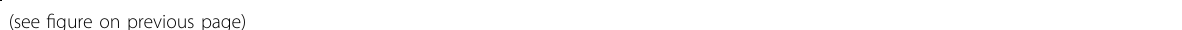
Fig. 6 Identi fi cation of CDCA3 as an miRNA target oncogenes. A Heatmap analyses demonstrating differentially expressed mRNAs in HCC with | log2fold-change | > 1.0 and P < 0.05. B , C Venn analysis between predicted mRNA genes targeted by miR-145-5p and differentially expressed mRNAs identi fi ed four mRNAs, NTN4, CDCA3, SLC25A25 , and SLC1A2 involved in HCC. D – G CDCA3 is signi fi cantly upregulated in HCC tumors and is associated with poorer OS. H Expression of CDCA3 between ten HCC tumor tissues and adjacent normal tissues measured by qRT-PCR (*** P < 0.001, n = 10). I Expression of CDCA3 between seven HCC tumor and adjacent normal tissues measured by western blot (** P < 0.01; n = 7). J CDCA3 protein expression in HCC and corresponding adjacent normal tissues detected by IHC ( n = 3). K Pearson correlation analysis demonstrating correlation between miR-145-5p and CDCA3 expression ( n = 20). L Pearson correlation analysis showing the correlation between hsa-circ-101555 and CDCA3 expression ( n =